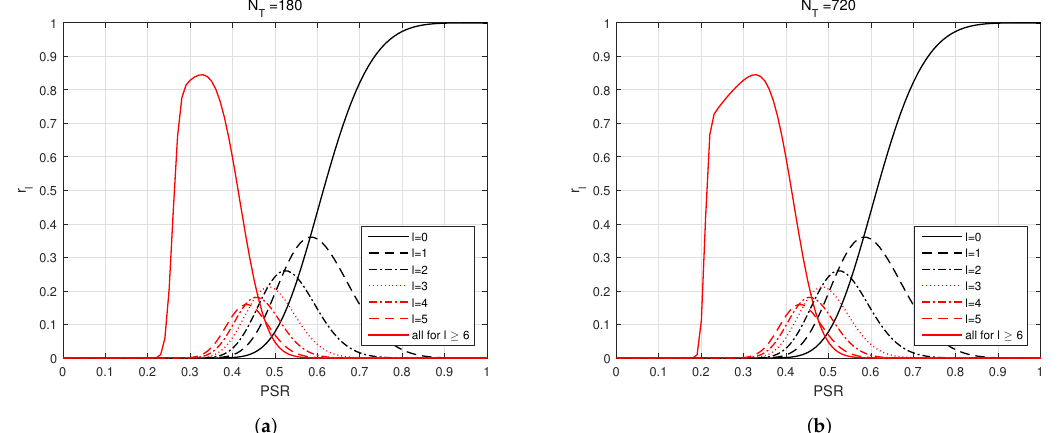
Figure 16. Probability comparisons at various (cid:96) . ( a ) N T = 180. ( b ) N T =